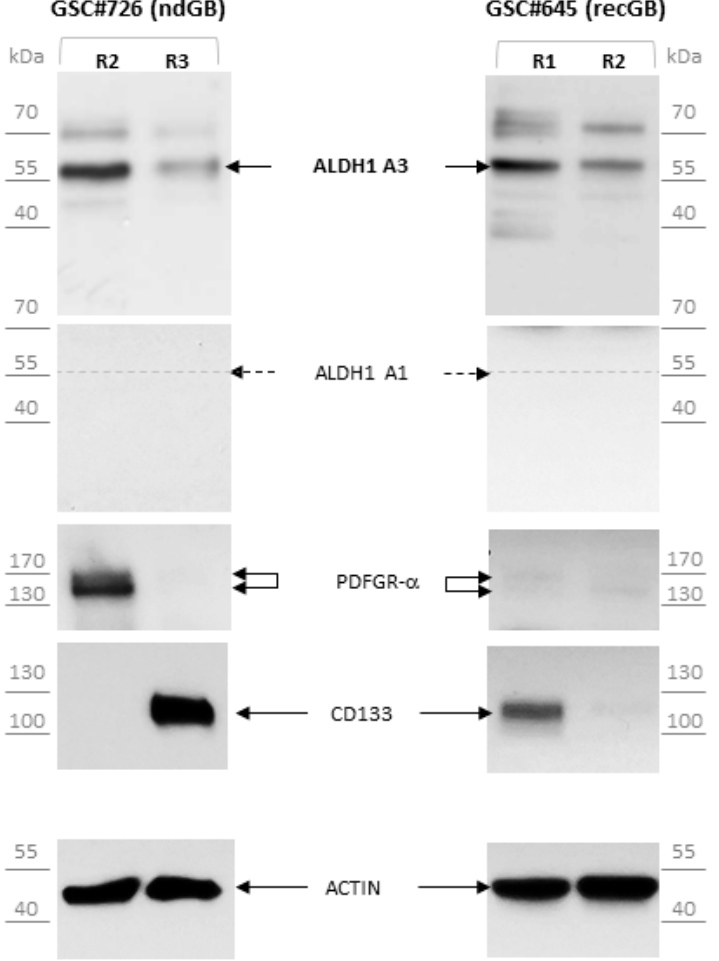
Figure 4. Comparative assessments of the CD133, PDGFRa and ALDH1 isoforms in isogenic GSCs by Western blot. “R1”, “R2” and “R3” designate different tumor regions from which isogenic GSCs were isolated. Isogenic GSCs show preferential expression of ALDH1A3 but not ALDH1A1. Considerable intratumoral variations in the levels of CD133 or PDFGR α do not mirror variations in the levels of ALDH1A3.